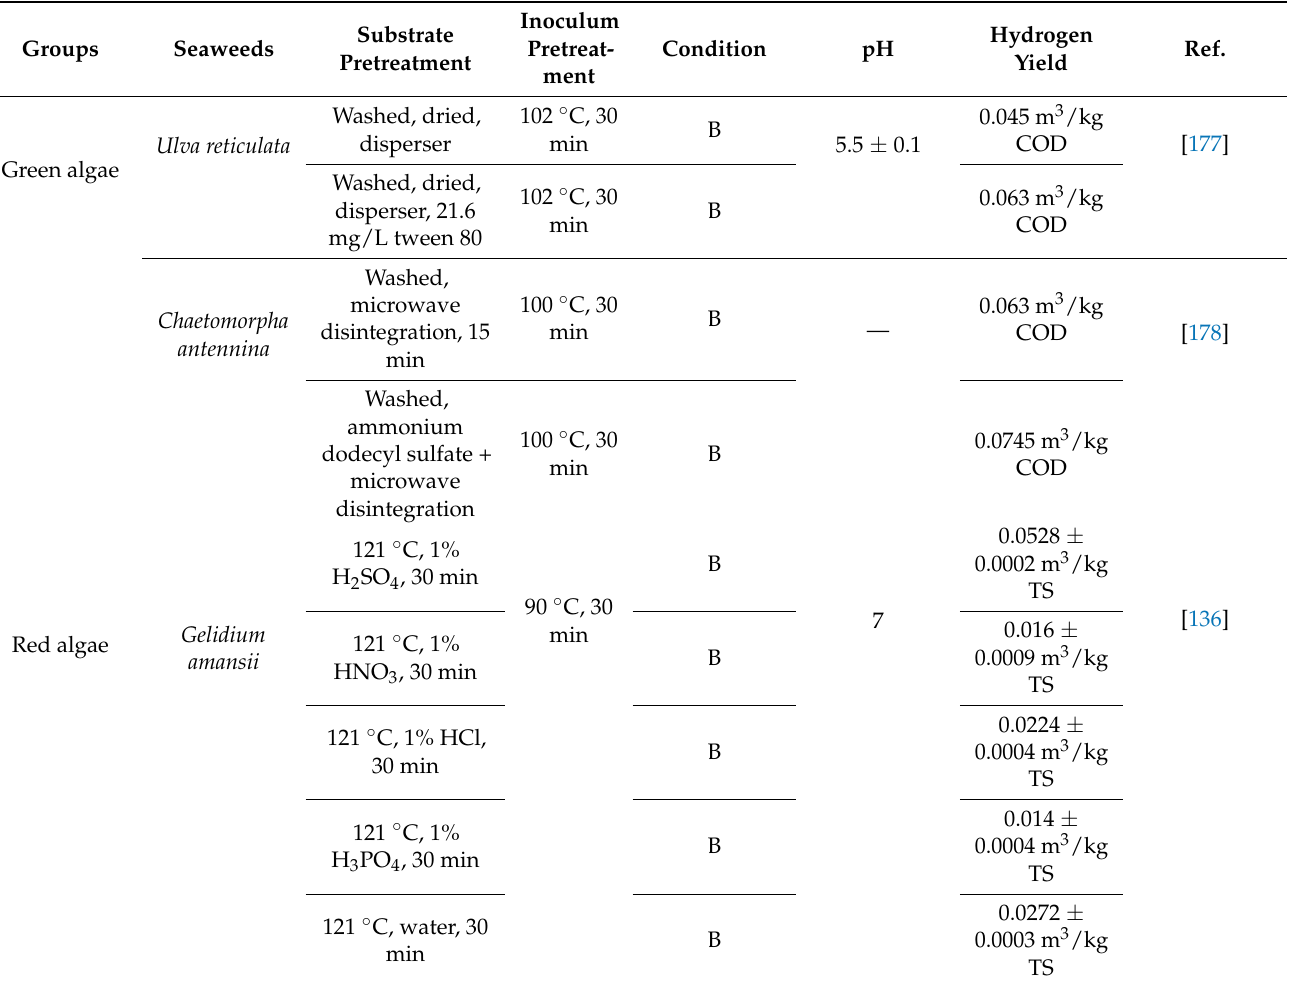
Table 4. Examples of biohydrogen production and operational conditions with seaweeds as a raw